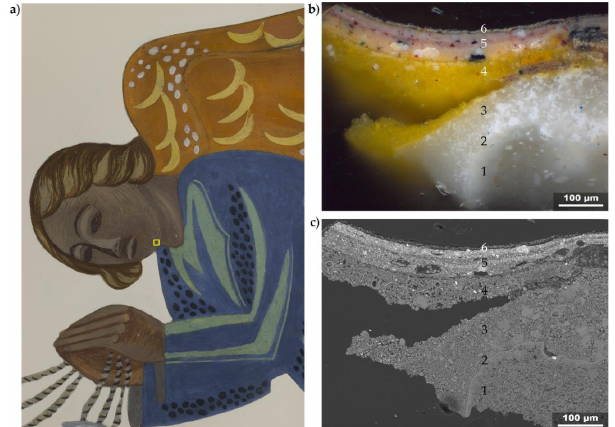
Figure 5. ( a ) Detail of one of the two angels (image size ca. 70 cm × 100 cm) above the Trinity in the south portion of the upper part of the vault with indication of the sampling area (yellow square); ( b ) optical microscope image and ( c ) SEM-BSE image of the cross-section of the micro-sample taken in the area shown in ( a ).